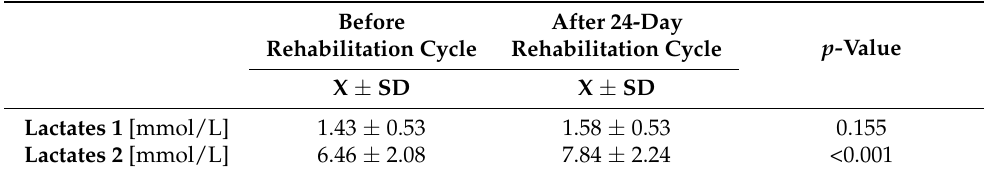
Table 5. Blood lactate level.